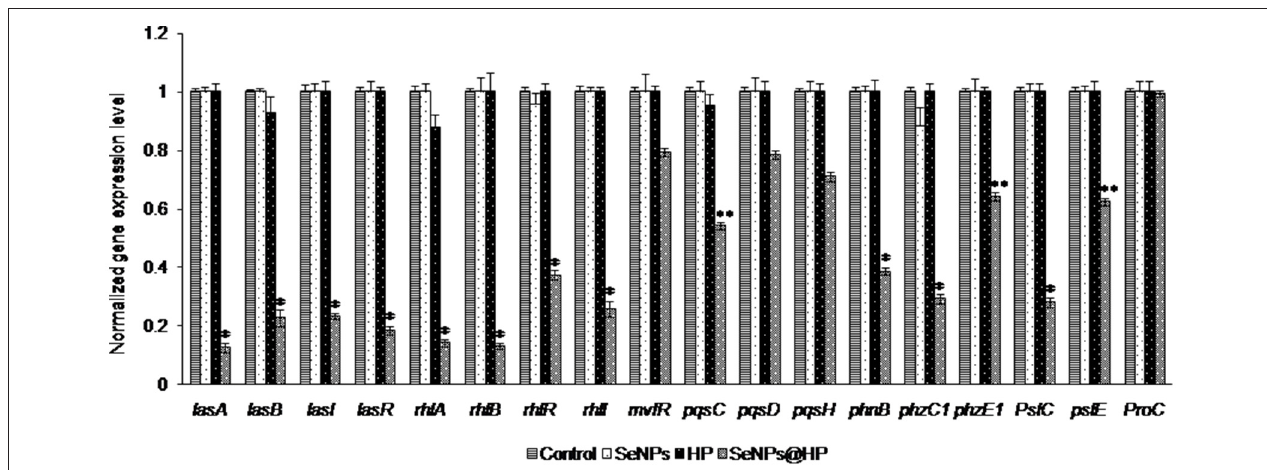
FIGURE 7 | Inhibitory effects of SeNPs@HP on the expression of QS-inducible genes through RT-qPCR analysis. RNA was extracted and employed for synthesizing cDNA from treated and untreated biofilm cells with SeNPs (7.5 µ g/mL), HP (0.6%), and SeNPs@HP (4.5 µ g/mL) for 24 h. The relative magnitude of gene expression level was defined as the copy number of cDNA of each gene in the biofilm cells normalized by the copy number of cDNA of the corresponding gene in biofilm cells without test sample. Error bars indicate the standard deviations of 3 measurements. ** p < 0.001 vs. the control. * p < 0.01 vs. the control.